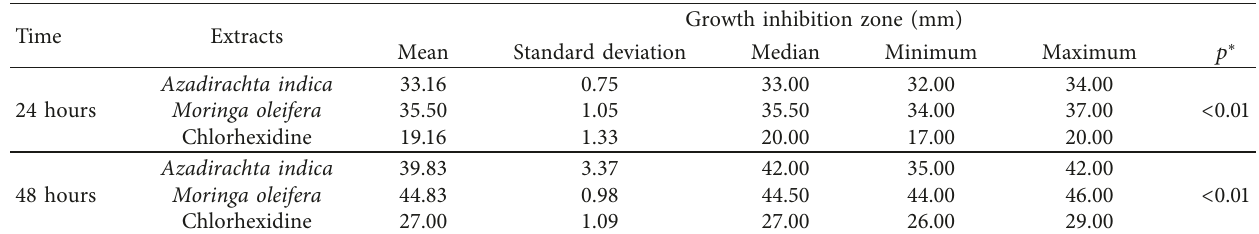
Table 1: In vitro antibacterial effect of 2% chlorhexidine and the methanolic extracts of Moringa oleifera and Azadirachta indica against Enterococcus faecalis during the first 24 and 48 hours.